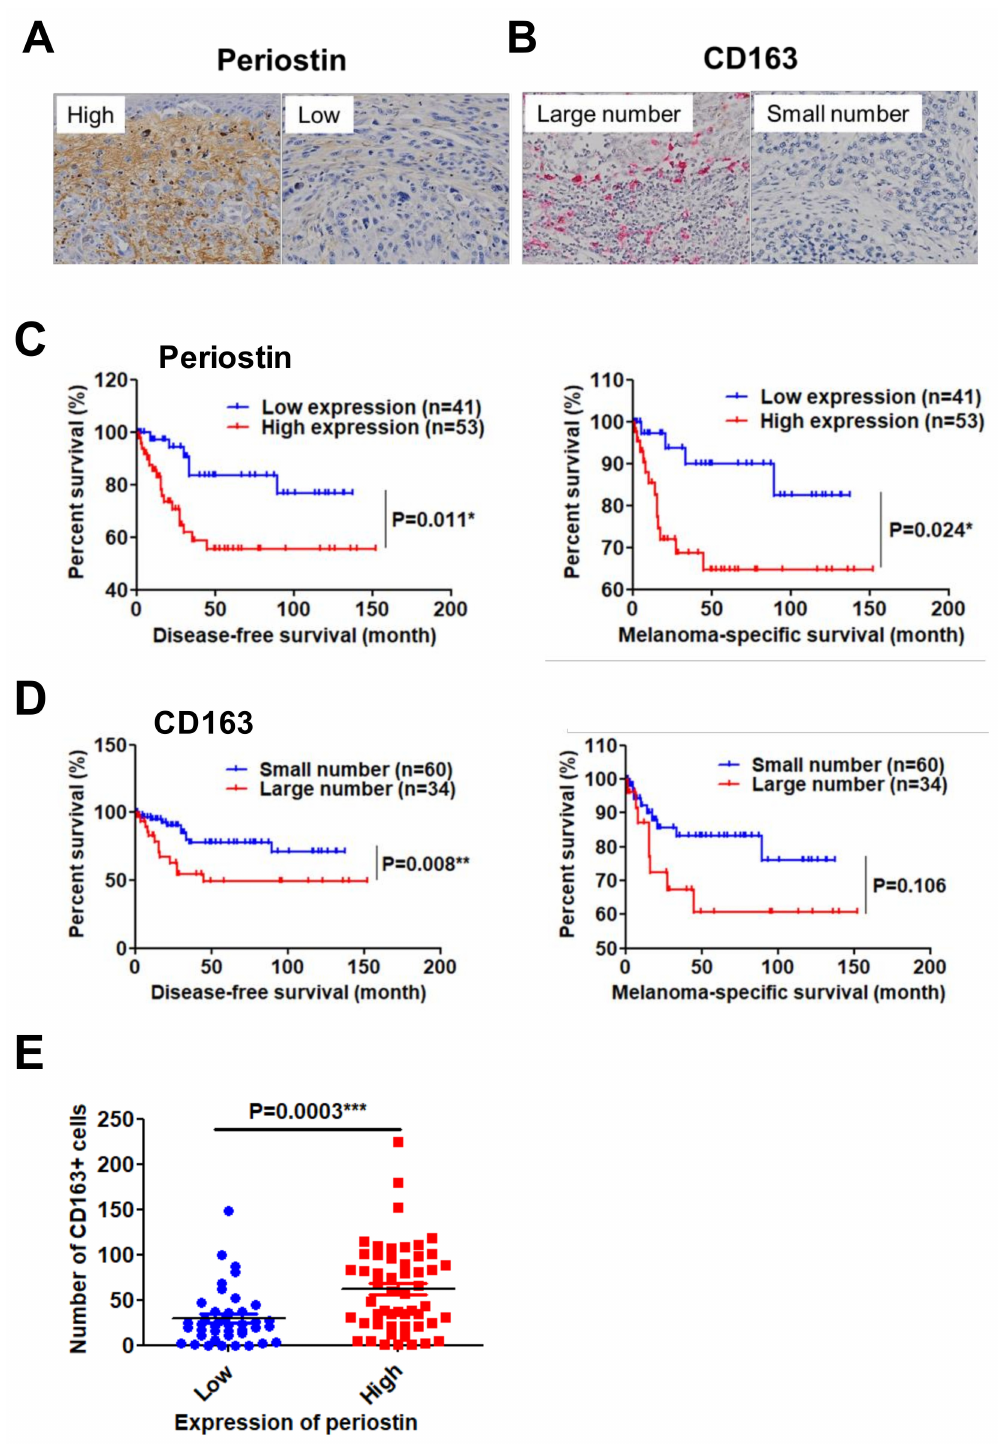
Figure 4. High periostin expression and a large number of infiltrated M2 macrophages are significantly correlated with poor prognosis in patients with melanoma. ( A , B ) Representative immunohistochemical staining of periostin ( A ) (brown) and CD163 ( B ) (red) in human melanomas. × 200 magnification. ( C , D ) Kaplan-Meier curve of 94 patients with melanomas regarding periostin ( C ) and CD163 ( D ) for DFS and MSS. p -values were obtained from the log-rank test (n, the number of samples in each group). * p < 0.05, ** p < 0.01. ( E ) Scatter diagram shows the relationship between the expression of periostin and the number of CD163 + M2 macrophages. Cut-off values for high/low expression of periostin and the number of CD163 + cells are described in the Results. t -test, *** p <